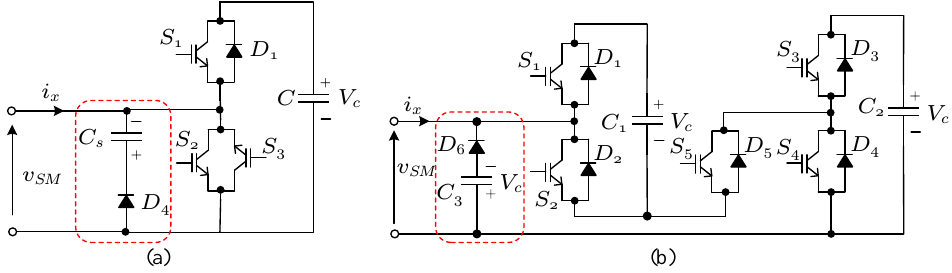
Figure 7. Bipolar SMs with bypass circuits: ( a ) BBSM/RBSM—Bidirectional blocking SM/Reverse blocking SM; and ( b ) RBDSM—Reverse blocking Double